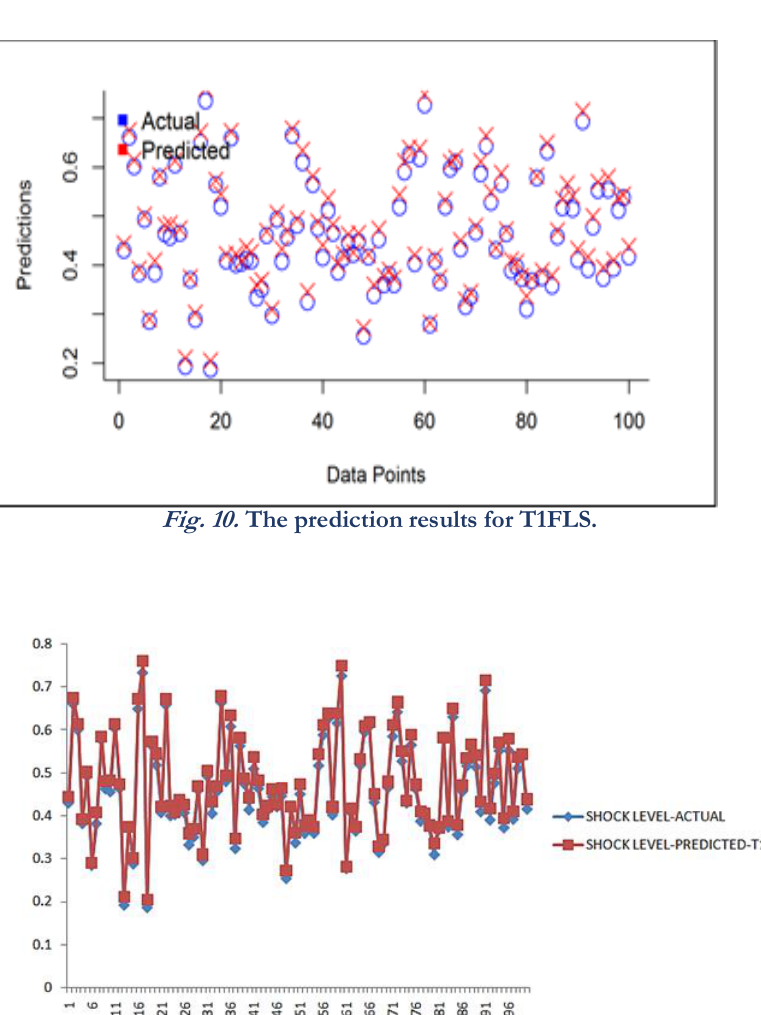
Fig. 11. System’s response of T1FLS for the actual and predicted shock